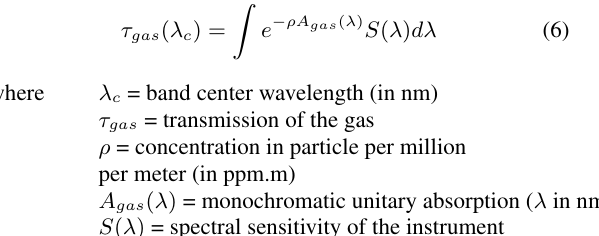
Figure 1. A : Section of the HySpex data above the chimney of the Lacq industries. B : Section of the AVIRIS data. The two images are displayed at 2.3 µ